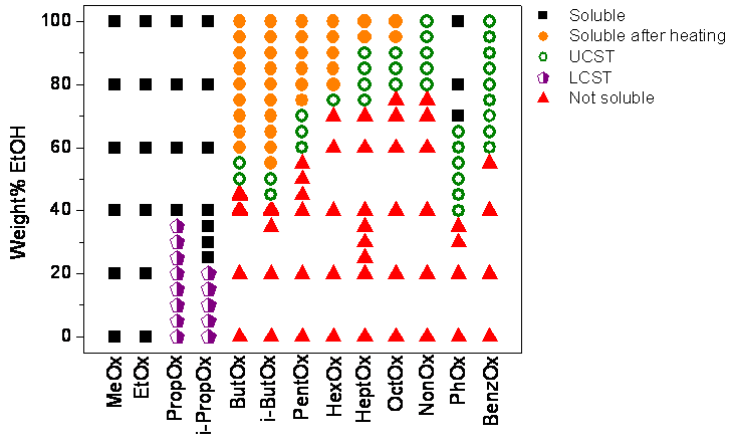
Figure 2. Solubility overview for poly(2-alkyl-2-oxazoline)s in water-ethanol mixtures (5